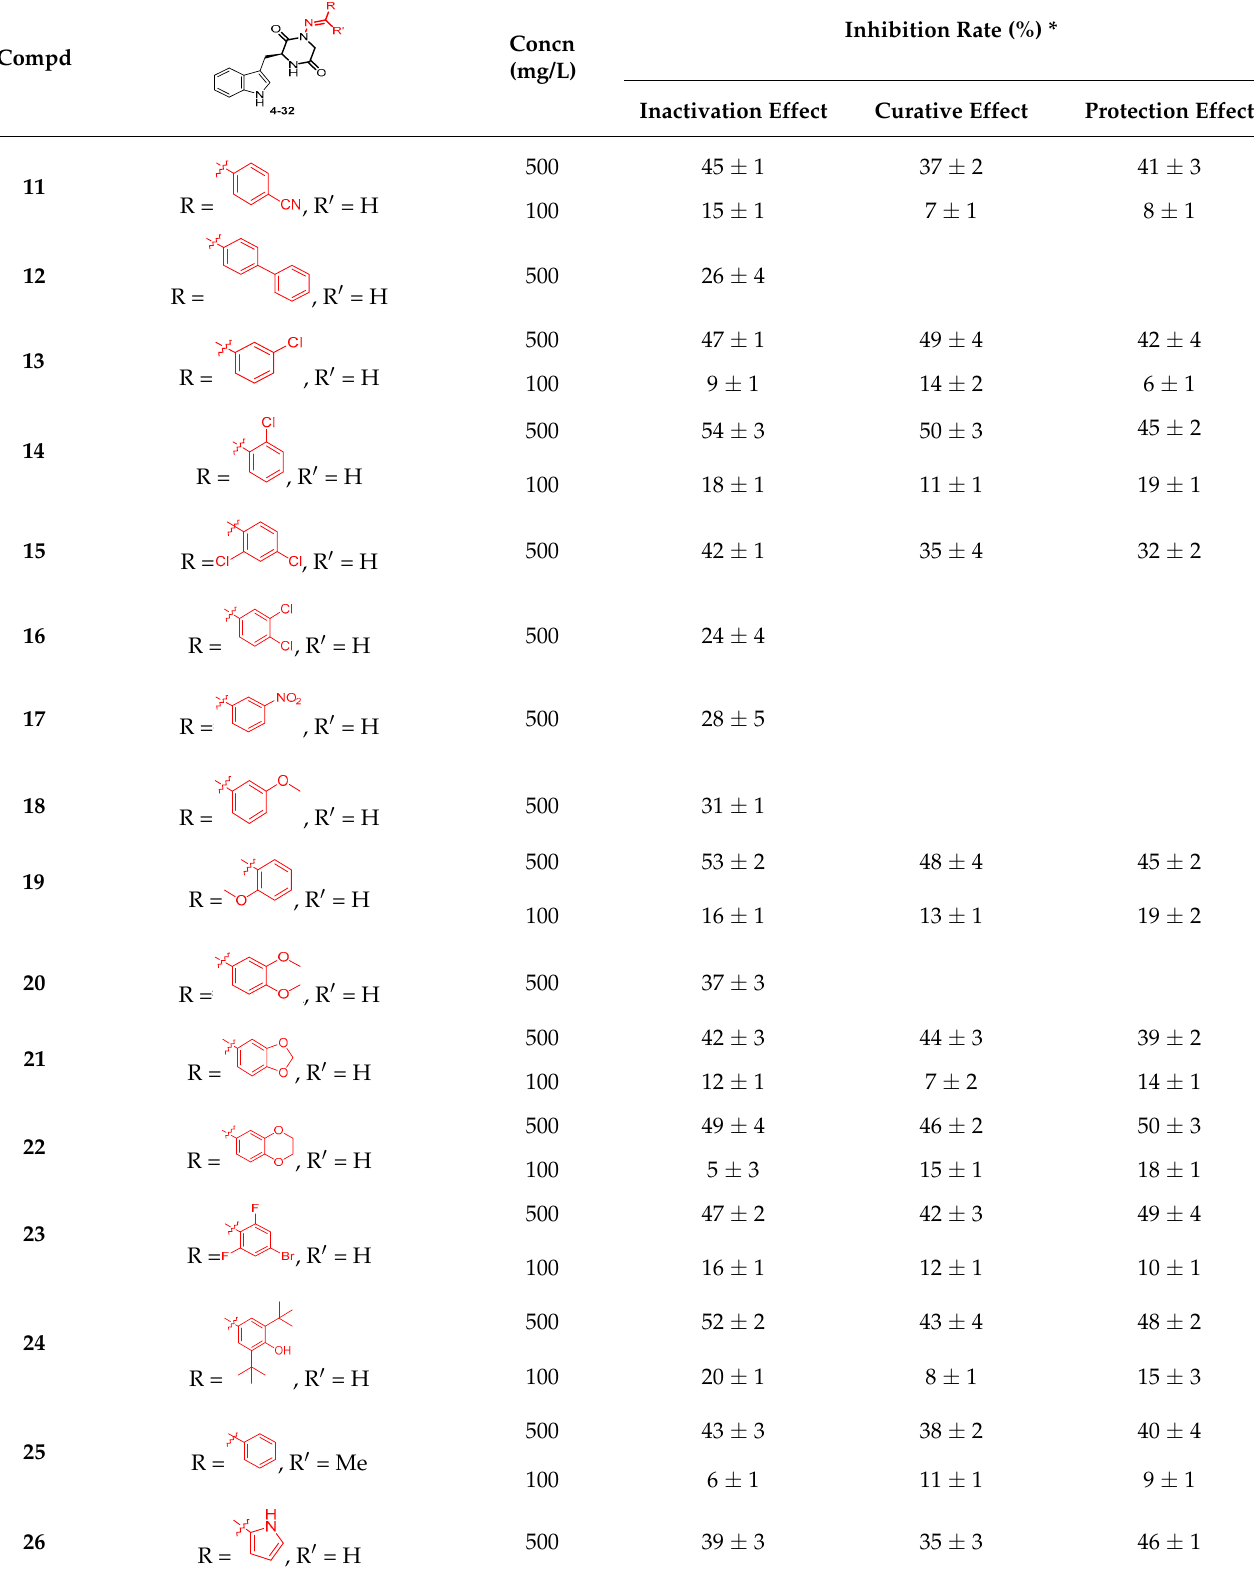
Table 2. Cont. Table 2. In vivo anti-TMV activities of compounds 3 – 32